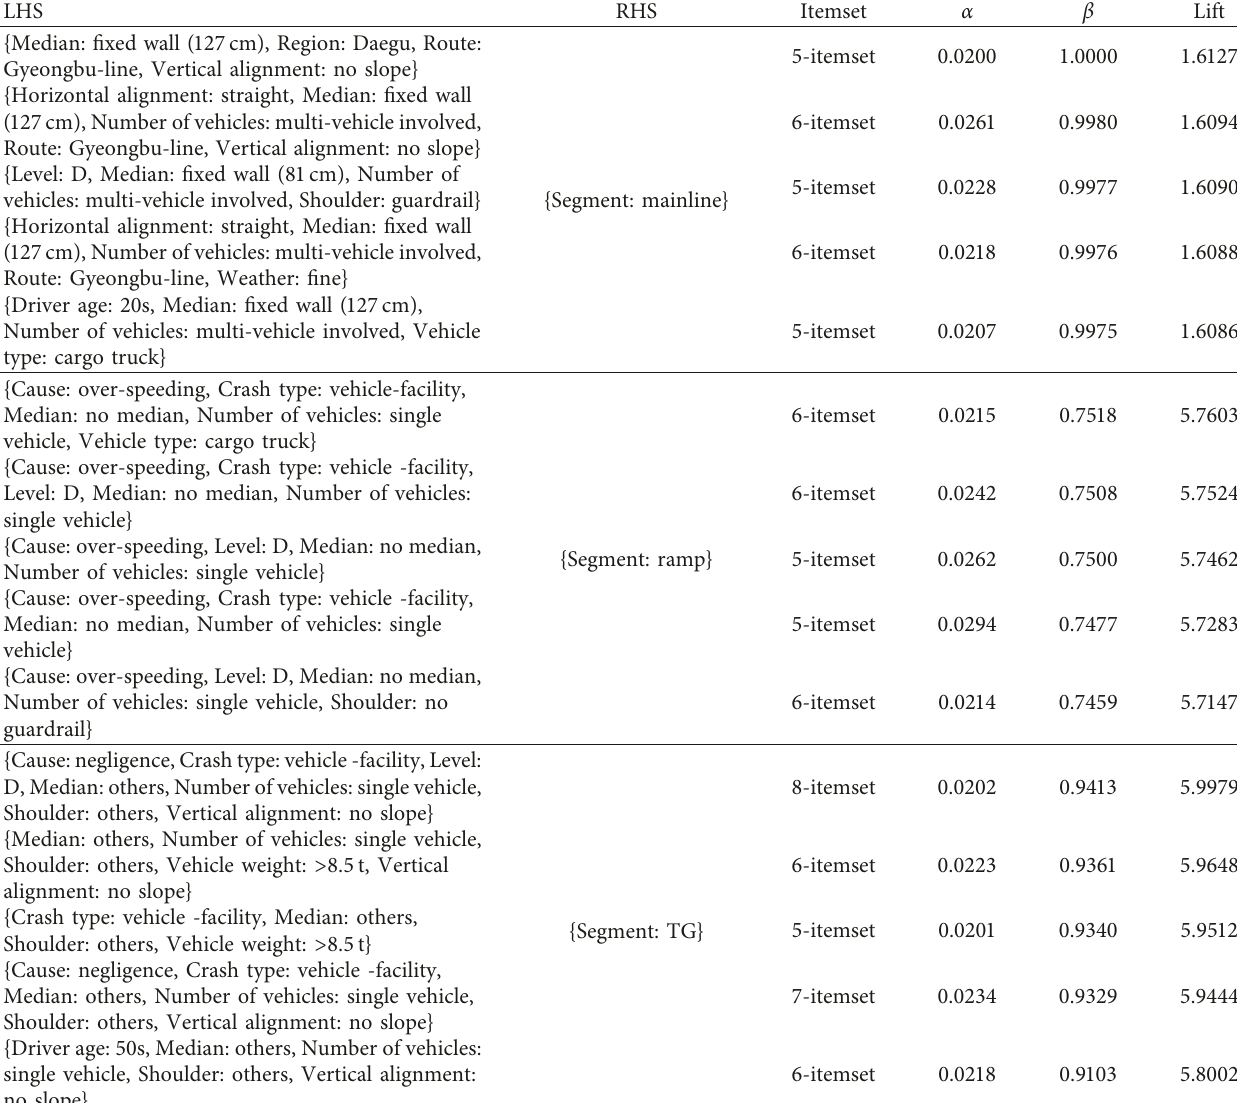
Table 4: Association rules by segment